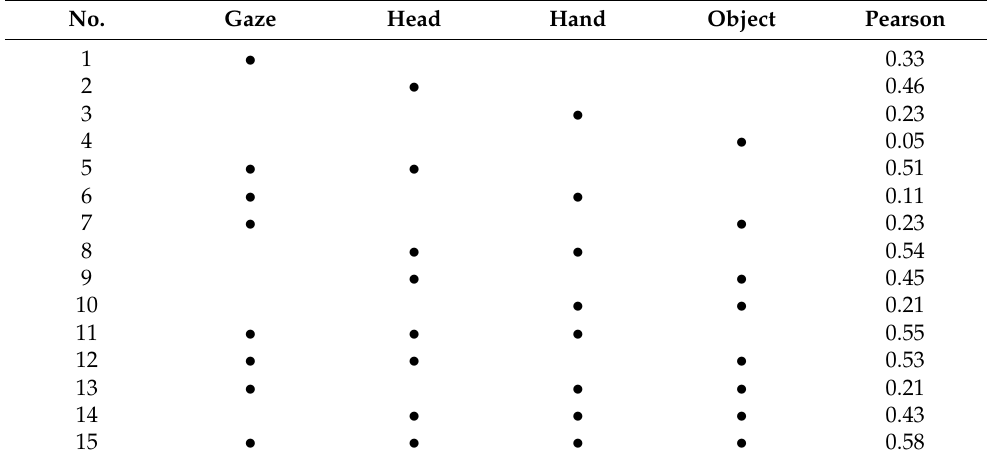
Table 1. Correlation between each measured interaction-information combination and user satis- faction.